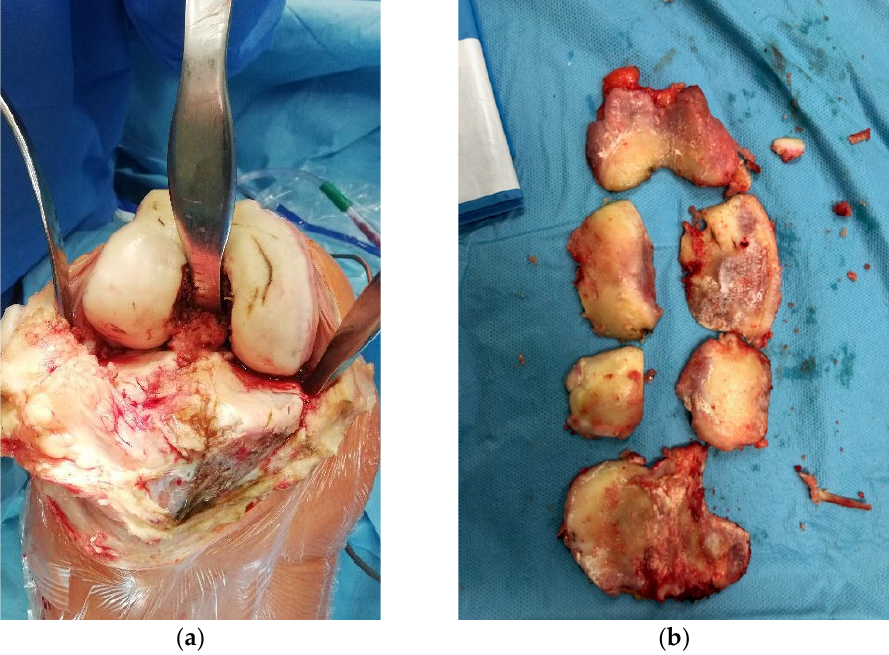
Figure 2. Intraoperative view prior ( a ) and after resection ( b ) of articular surfaces of the tibio-femoral joint.